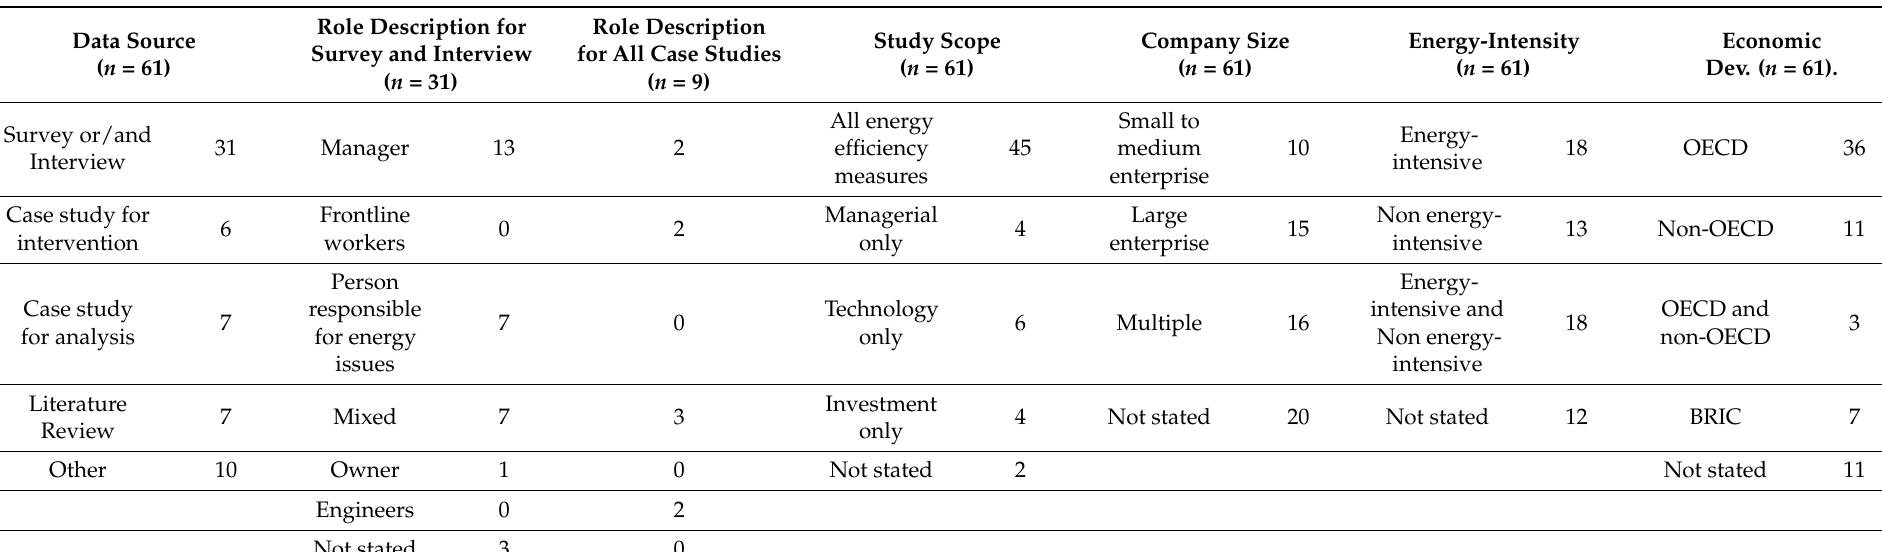
Table 1. Summary of results from systematic literature review on how academia learns about drivers showing the number of papers for each